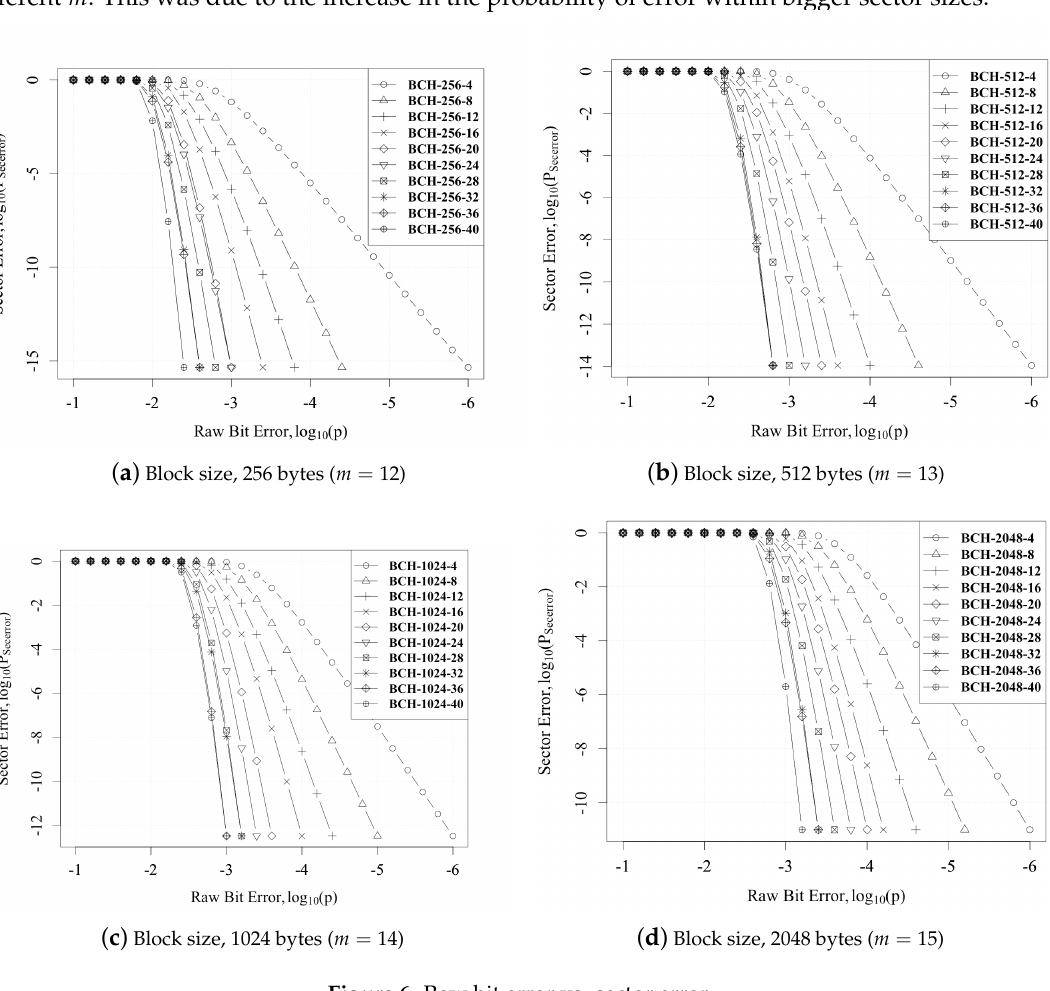
Figure 6. Raw bit error vs. sector